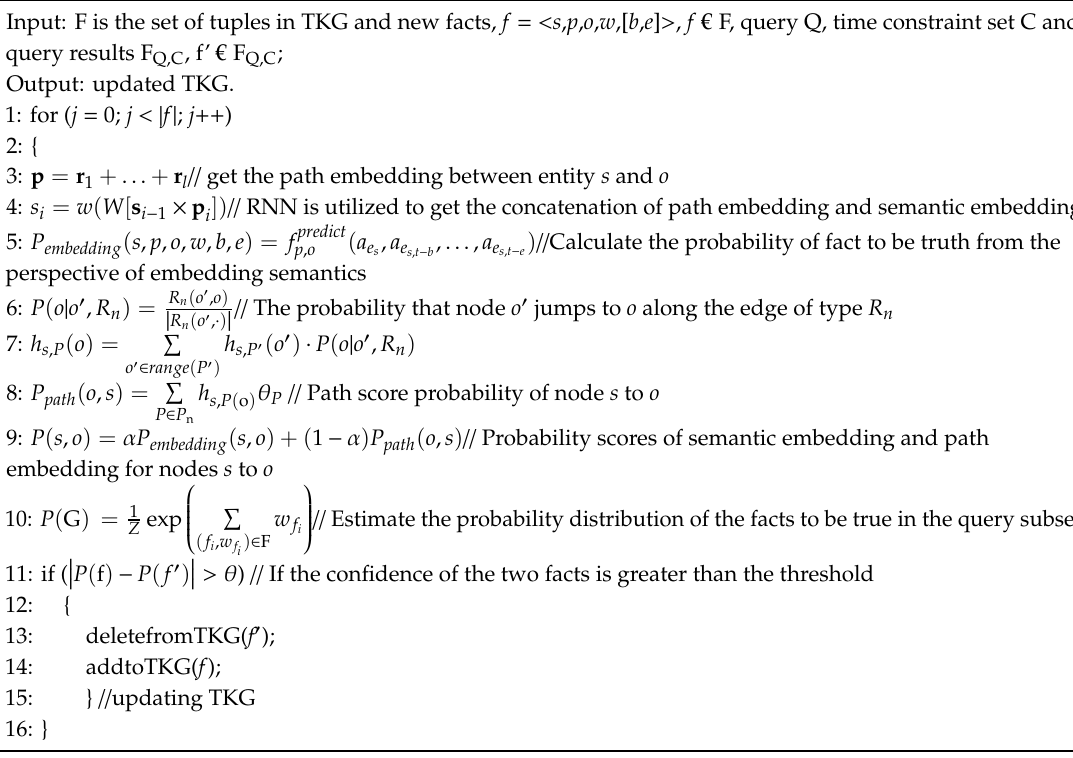
Algorithm 1. Knowledge graph evolution algorithm based on deep